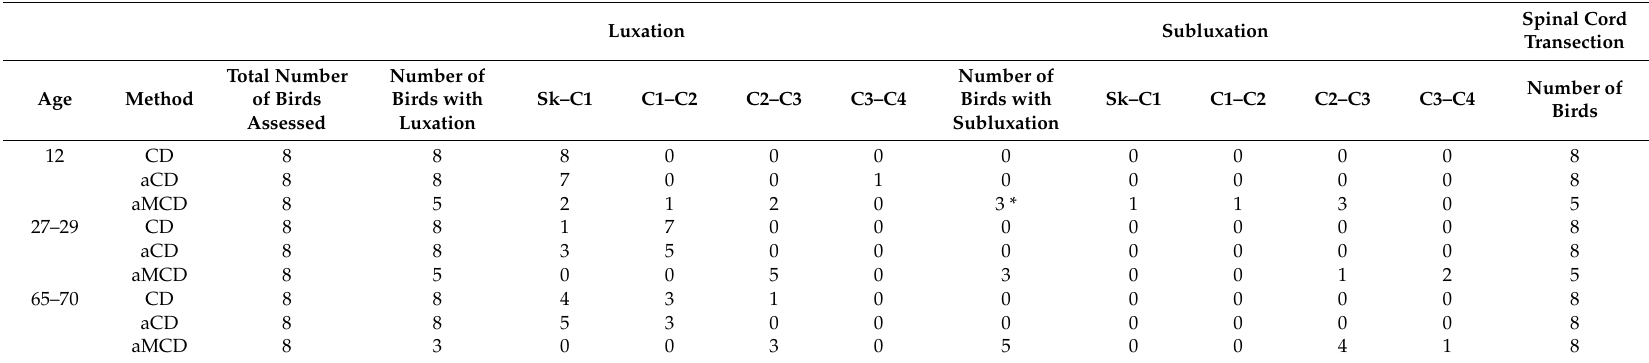
Table 8. Presence and location of luxation / subluxation (from radiographs) and spinal cord transections (from macroscopic evaluation) in conscious and anesthetized chickens killed by manual cervical dislocation and KED 1 . Values indicate number of